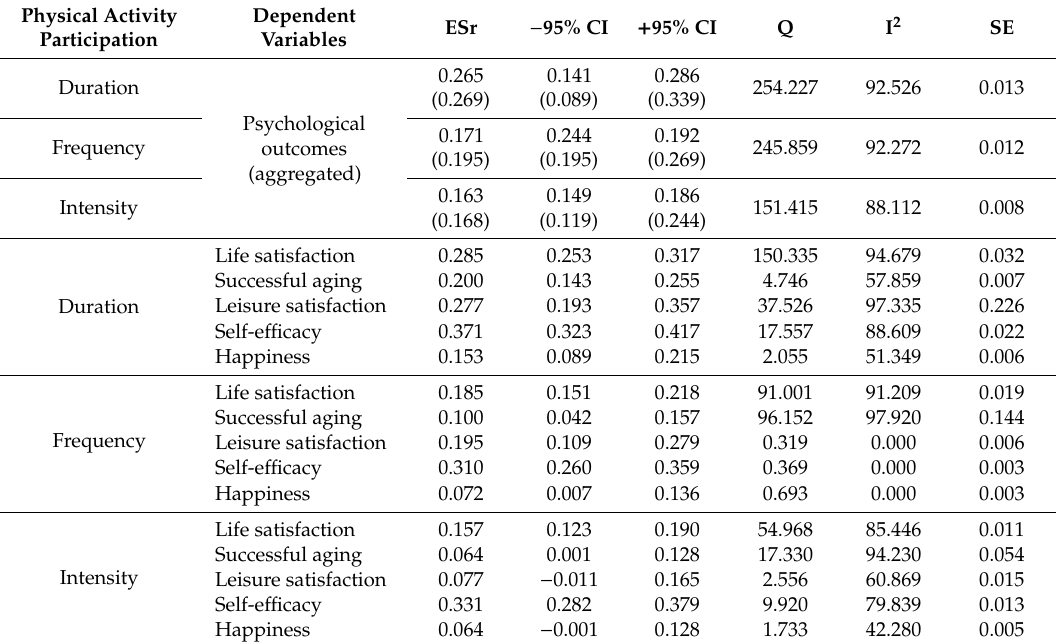
Table 3. E ff ect sizes of three sub-components (exercise